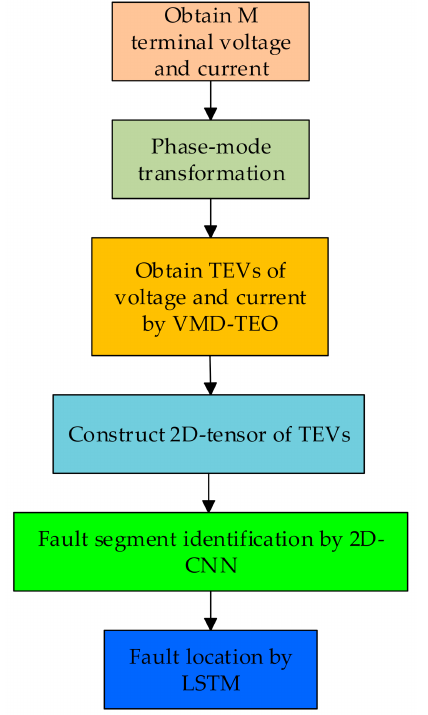
Figure 6. Fault location based on CNN-long short-term memory